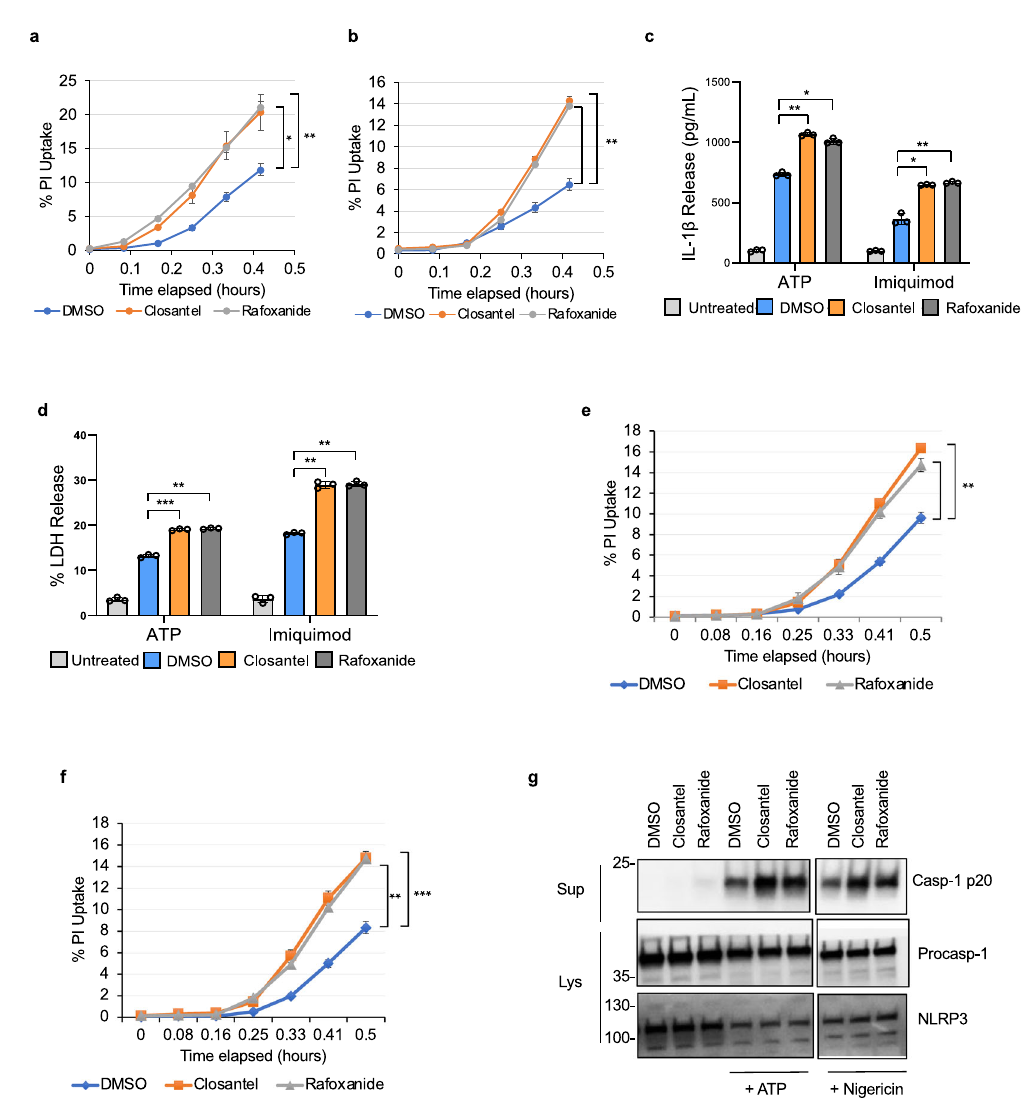
Fig. 4 Pharmacological inhibition of STK39/OXSR1 increases NLRP3 in fl ammasome activation in macrophages. Propidium iodide uptake of LPS-primed imiquimod ( b ). P values for a are 0.011432 and 0.00492; b are 0.00162 and 0.00091. IL-1 β ( c ) and LDH ( d ) release in culture supernatants of